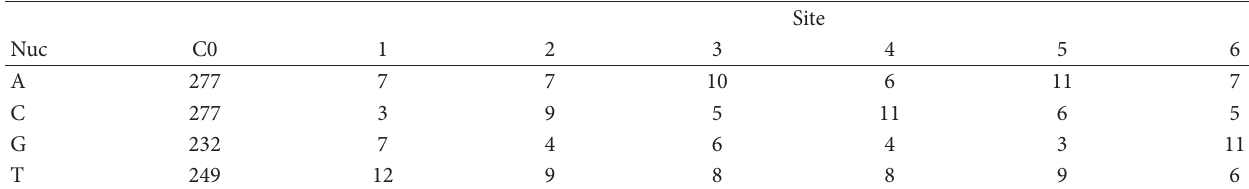
T 5: Site-speci�c distribution of nucleotides from the 29 initial motifs of length 6, aer replacing the initial A the new motif (= TCACAG).